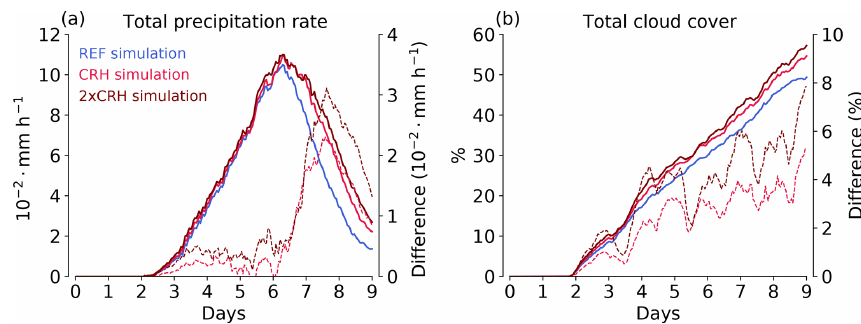
Figure 4. Evolution of spatially averaged (a) total precipitation rate and (b) total cloud cover for different treatments of cloud-radiative heating. The dashed lines denote the differences of the CRH and 2xCRH simulations with respect to the REF simulation. For the differences, the right y -axis is